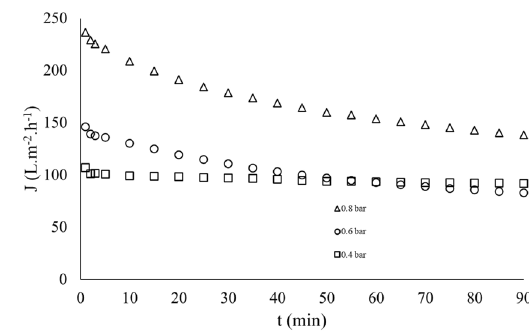
Figure 7. Permeate fluxes in different pressures for M2 membrane under different conditions.